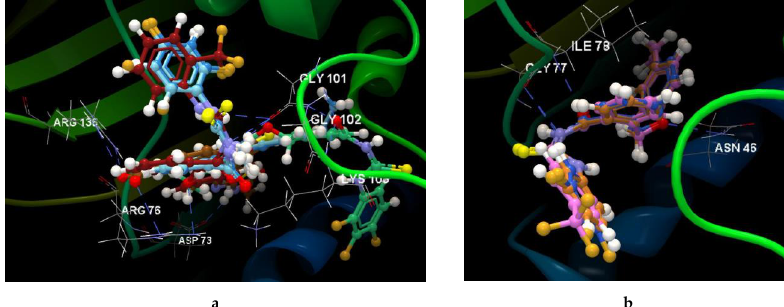
binding modes of ligands have been validated by redocking (Figure 6c, 6e, 6h, and S4). According to